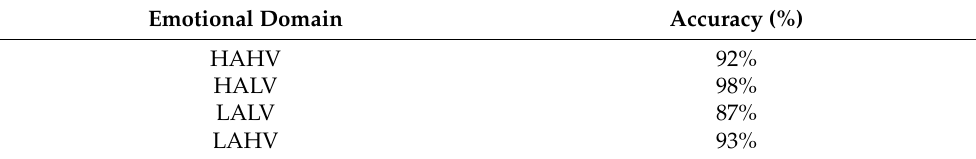
Table 4. Results of the recognition accuracy of emotional photos in each emotional domain.